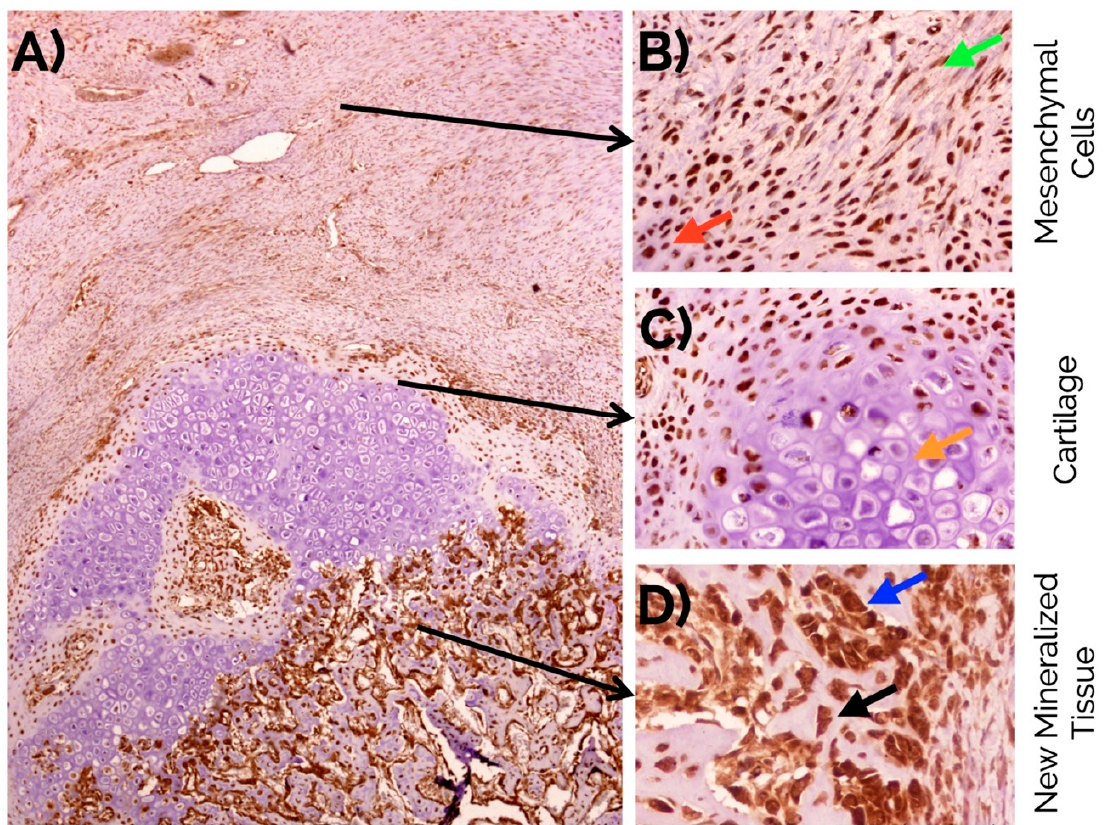
Figure 4. ( A ) Overview of musashi-1 detection in a bone fracture callus (in brown) and detail observations in ( B ) fusiform mesenchymal cells (green arrow), and immature chondrocytes (red arrow) in the fibrocartilage, ( C ) negative detection in mature hypertrophic chondrocytes (orange arrow), and ( D ) intense detection in the nucleus and cytoplasm of osteoblasts (blue arrow), and osteocytes (black arrow) in the newly formed bone. Peroxidase-conjugated micropolymer detection in samples from the 14-day time point. Original magnification: 10× ( A ), 20× ( B , C ) and 40× ( D ).